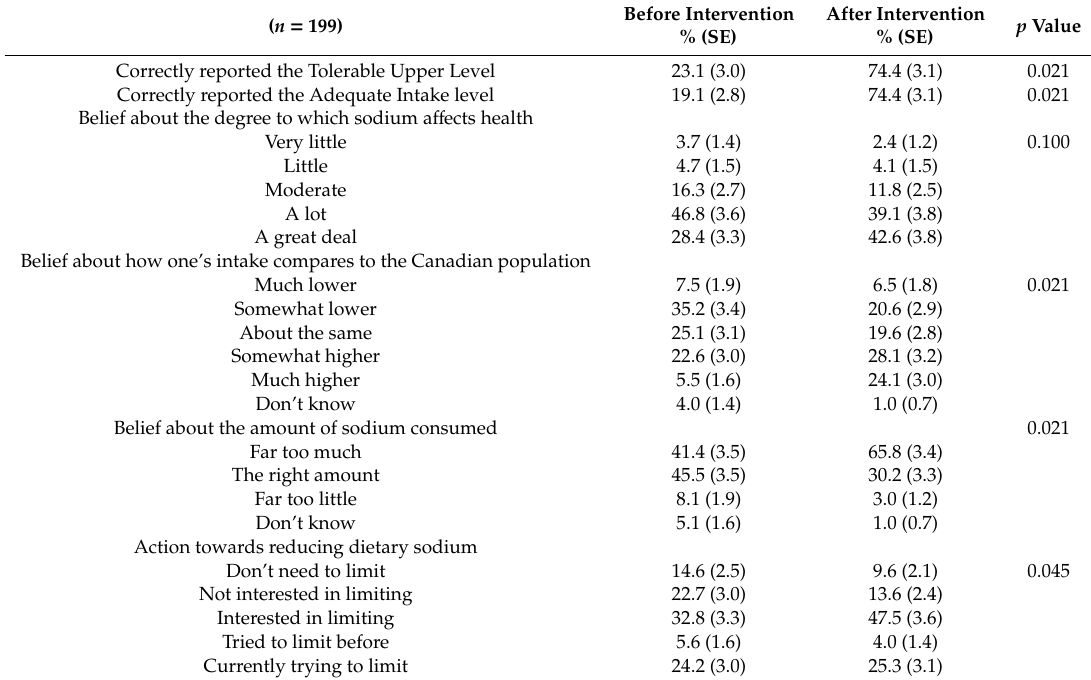
Table 1. Participant sodium-related knowledge and